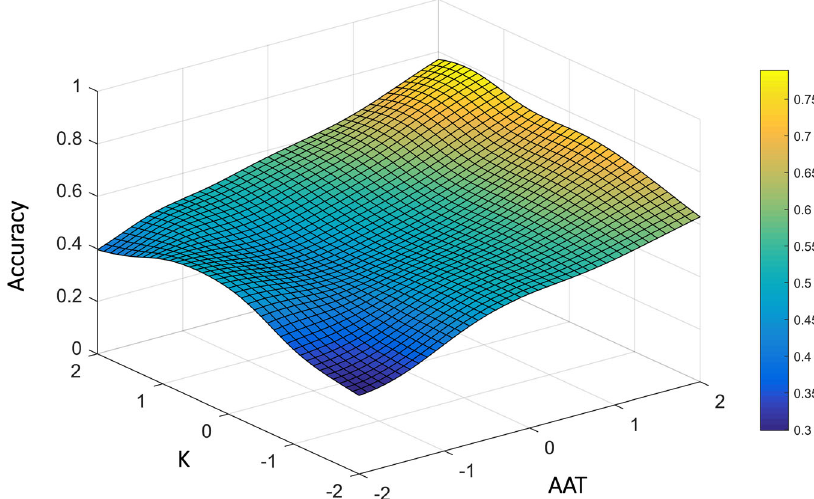
Fig. 3 Results of study 2. Accuracy as a function of AAT score and working-memory capacity ( K max